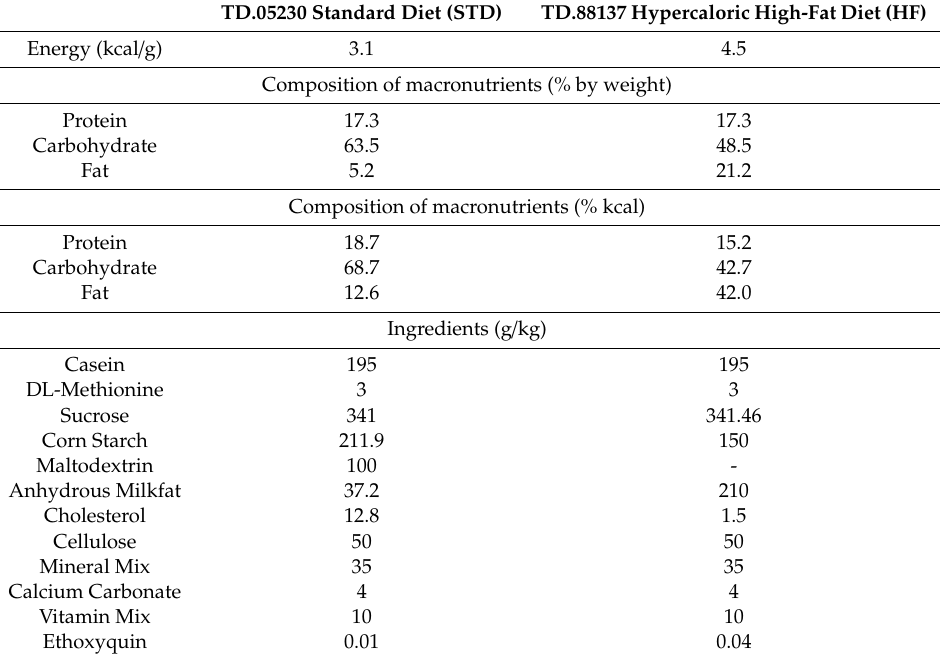
Table 1. Composition of test